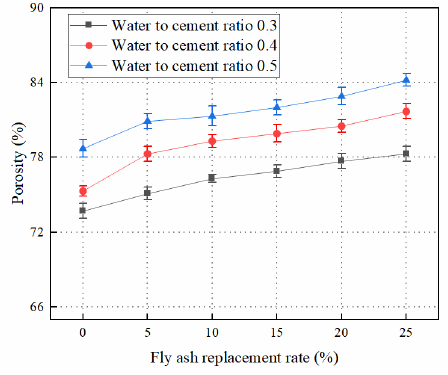
Figure 6. The porosity of foam concrete with different matching ratios.